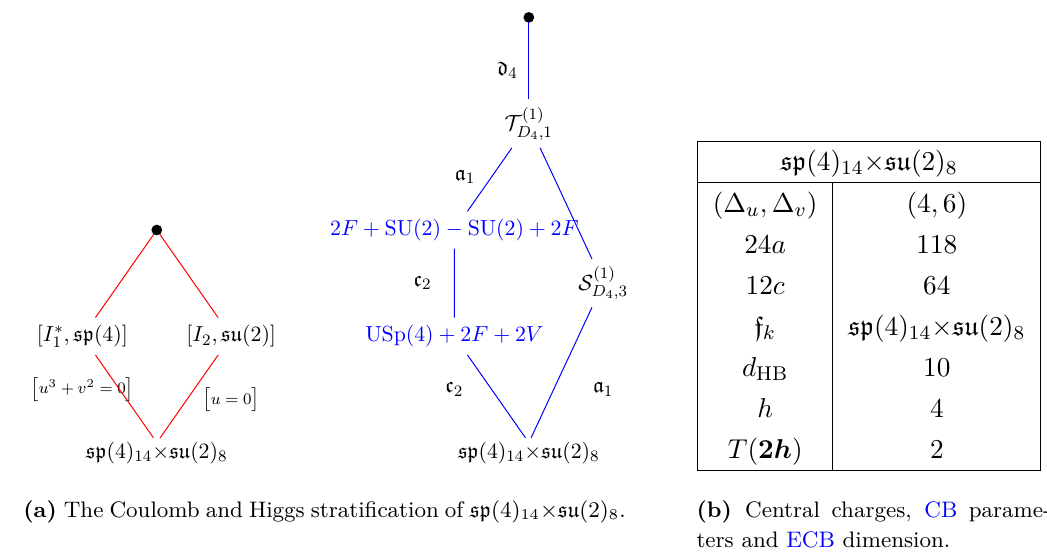
Figure 42. Information about the sp (4) 14 × su (2) 8